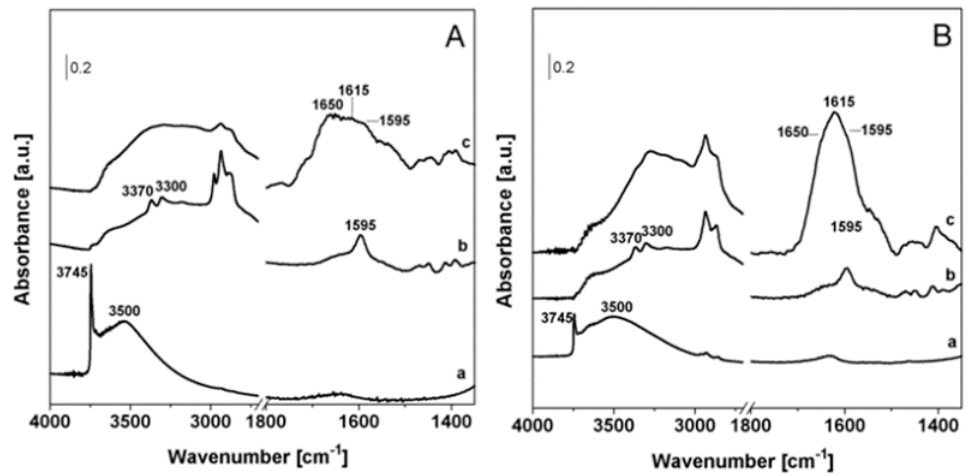
Figure 2. IR spectra, collected at RT and under vacuum of MCM-41 ( A , curve a), NH 2 -MCM-41 ( A , b), TbDO3A-MCM-41 ( A , c), SBA-15 ( B , a), NH 2 -SBA-15 ( B , b) and TbDO3A-SBA-15 ( B , c).